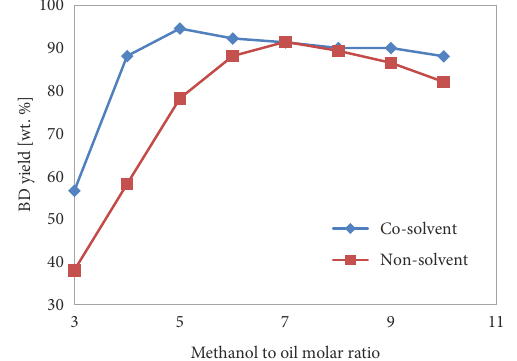
Figure 2. Influence of methanol to oil molar ratio on BAO conversion